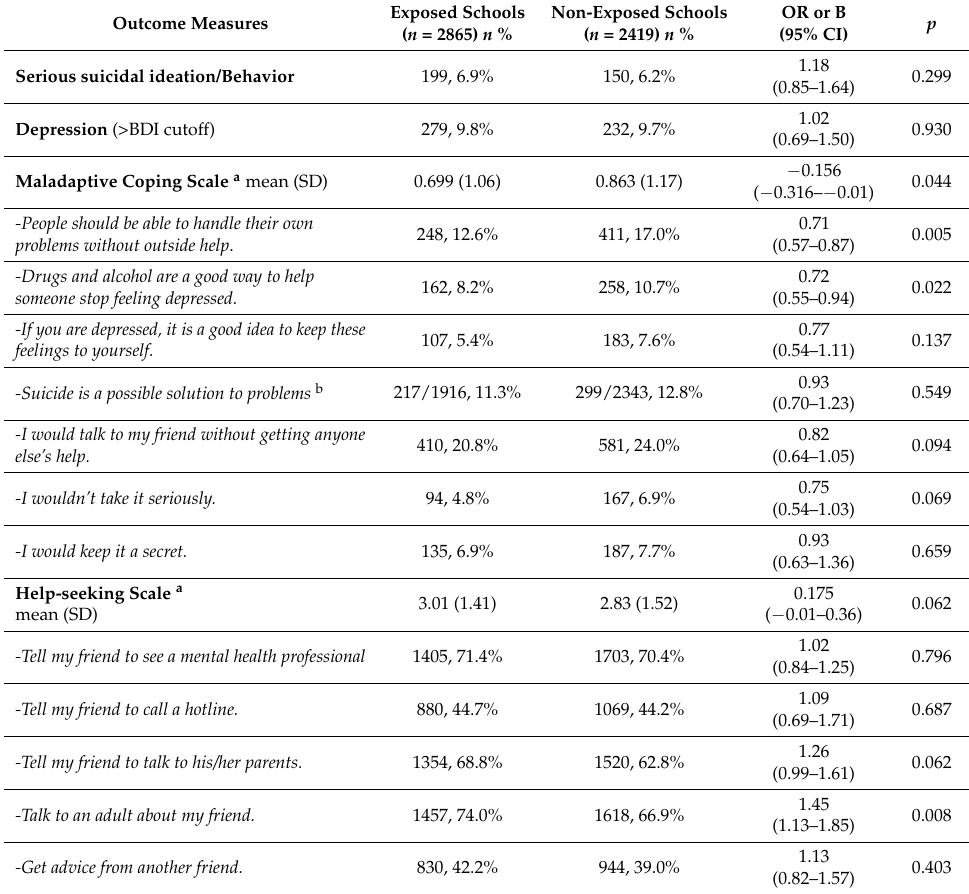
Table 1. Associations of Exposure to Schoolmate’s Suicide in School with Suicidal Ideation/Behavior, Depression, Maladaptive coping strategies and Help-seeking strategies. Outcome